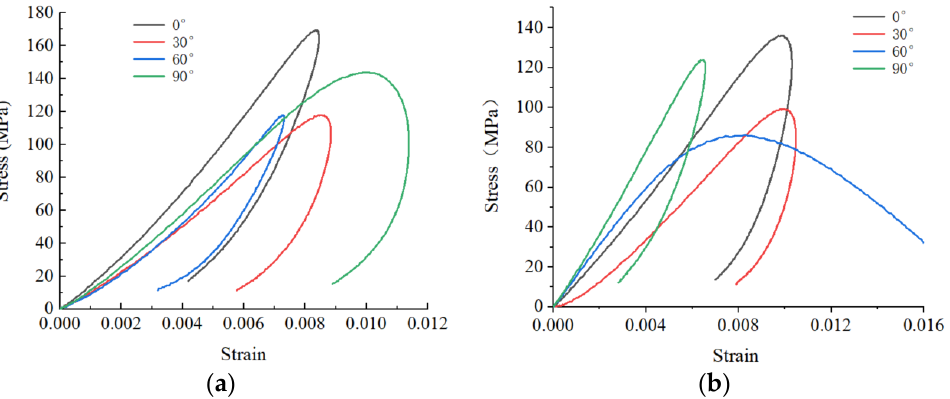
Figure 5. Stress-strain curves of samples with different stratification angles: ( a ) stress-strain curve in dry condition; and ( b ) saturated stress-strain curve.